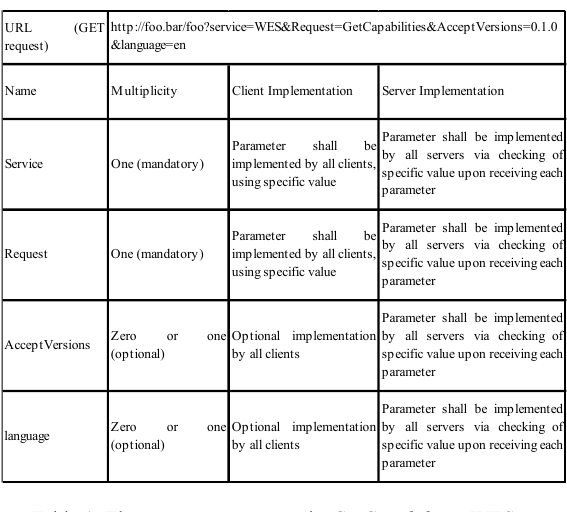
Table 1. The request parameters in GetCapabilities WES.